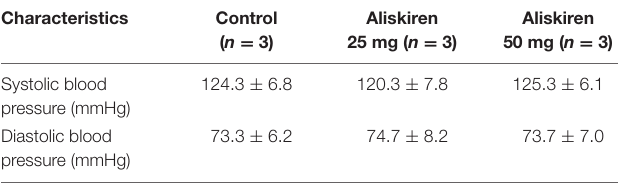
TABLE 3 | Blood pressure in sham-operated mice.